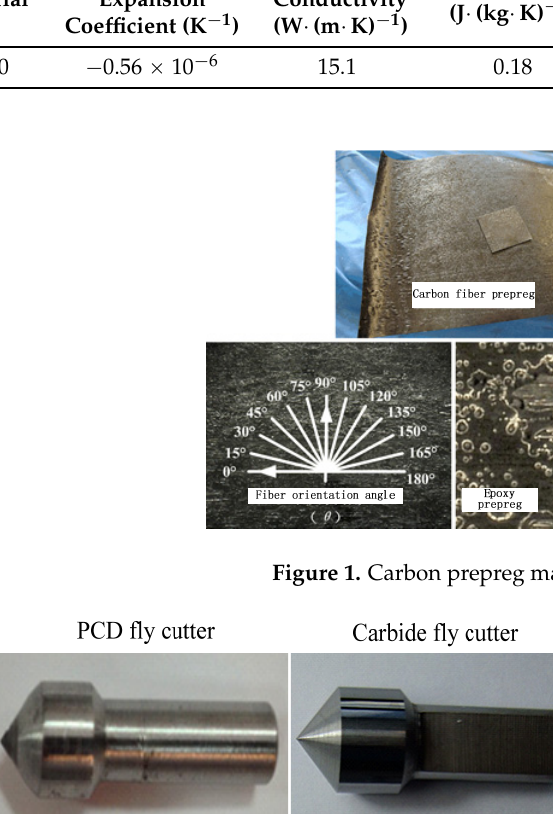
Figure 2. Cutting tools in experiments.